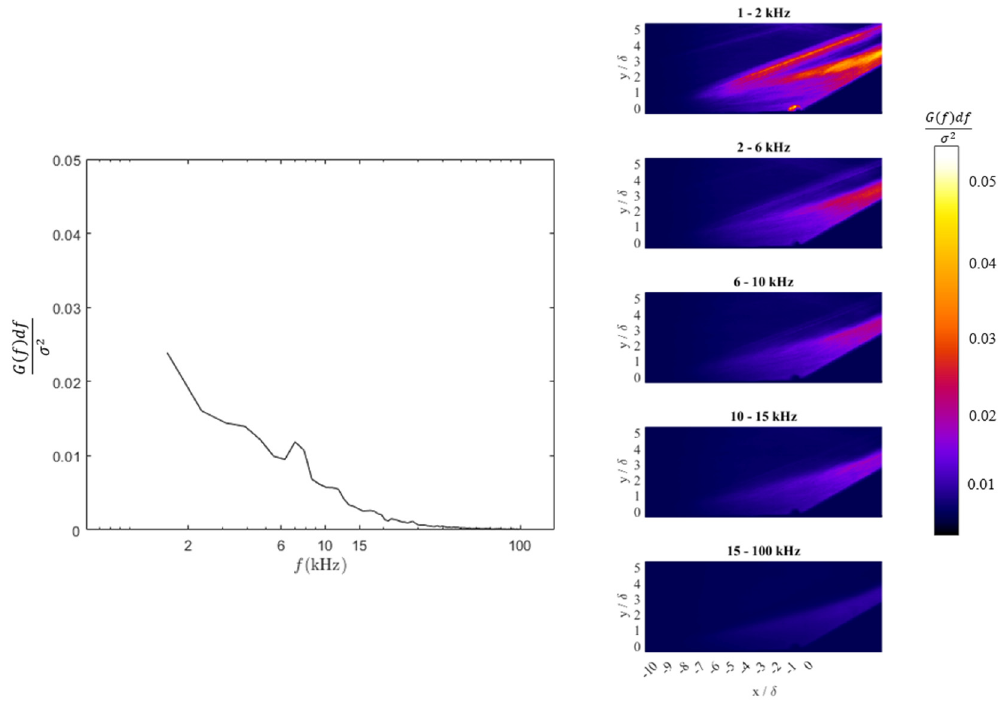
Figure 12. Normalized power spectra of high-speed schlieren images, averaged over different frequency bands for rough surface.